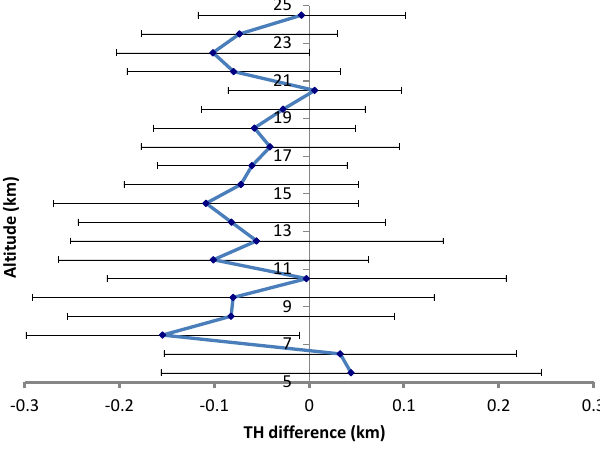
Figure 5. TH differences (this work minus ACE v3.x) averaged over 120 randomly selected occultations covering latitudes in the range 80 ◦ N to 68 ◦ S and spanning from January 2009 to January 2011. The error bars indicate the standard deviation of these differences. Note that each occultation does not provide data at all altitudes be- cause of the TH sampling is typically 1–2km but varying with beta angle and the lowest tangent height is often determined by the alti- tude of high, optically thick